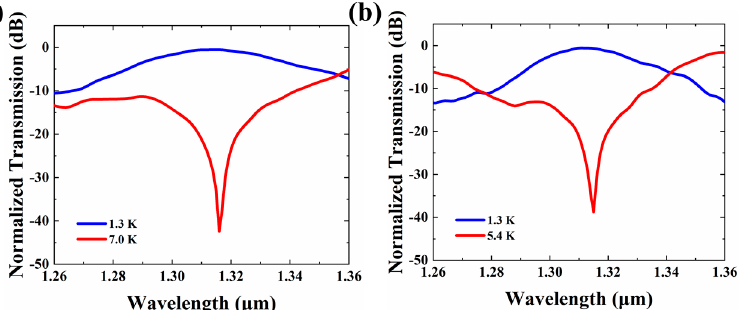
Figure 5. Normalized transmission under on-off voltage temperature with a length of ( a ) 3092 μ m and ( b ) 4642.5 μ m.